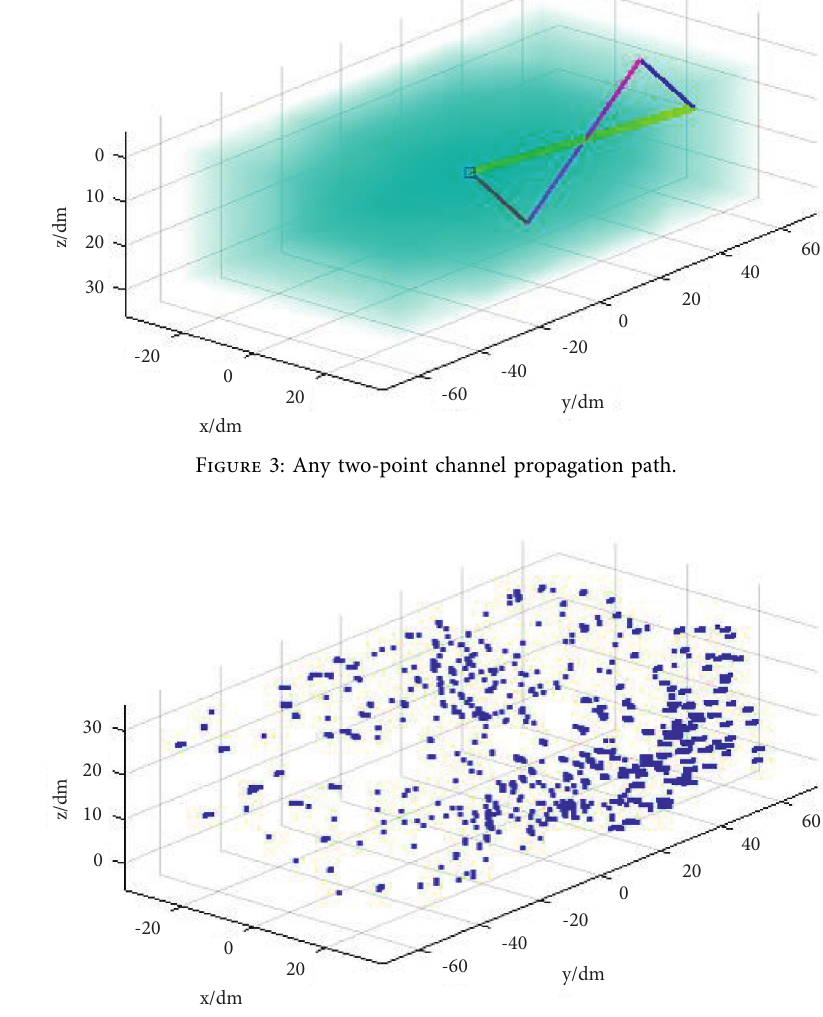
Figure 4: Influence of metal on wireless channel.